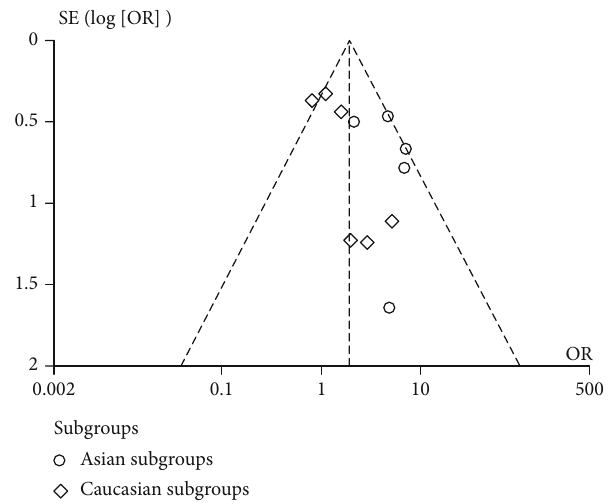
Figure 6: Funnelplotforstudiesof AGT p.Thr174Metpolymorphism associated with myocardial infarction using a recessive genetic model (MM vs. TM+TT). OR: odds ratio; SE: standard error.